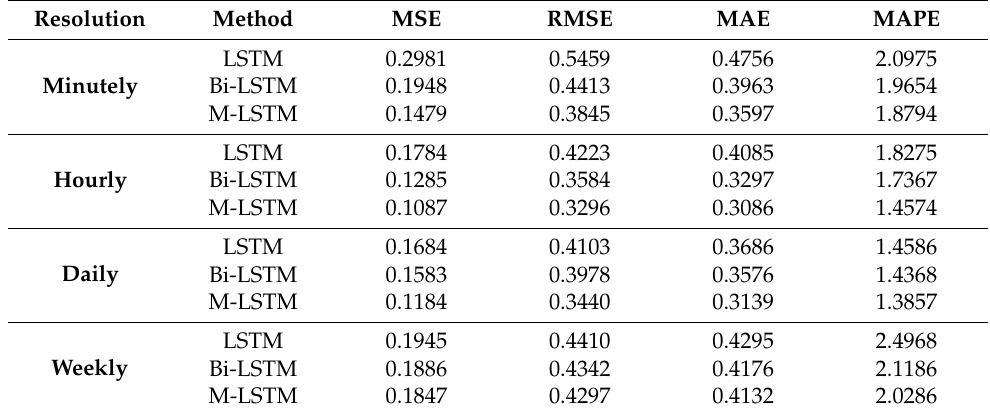
Table 11. Results obtained for sequential learning algorithm on different horizons using hold-out